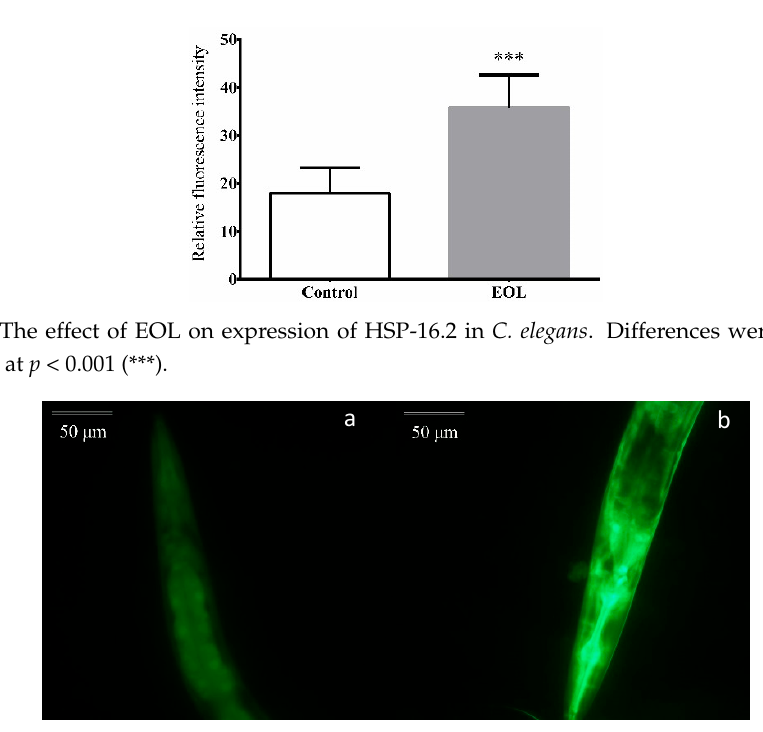
Figure 7. The expression of HSP-16.2 in C. elegans . ( a ) Treated with 1% DMSO. ( b ) Treated with EOL.